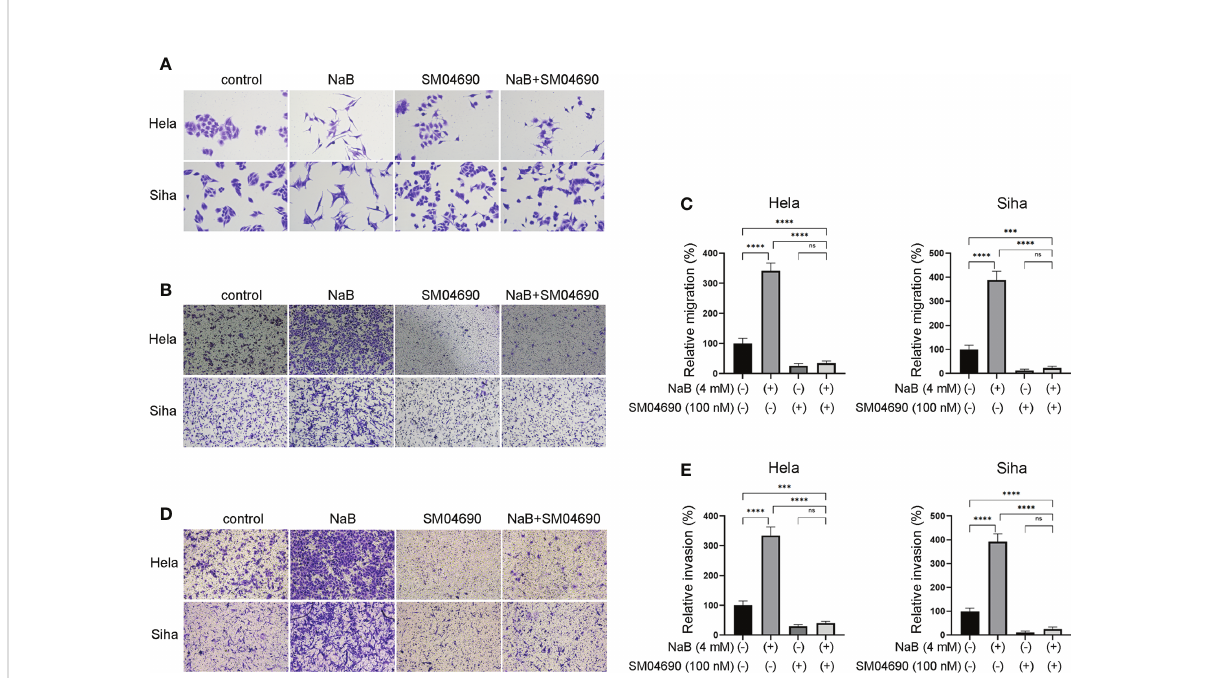
FIGURE 5 Wnt pathway inhibitor SM04690 relieved the effects of NaB on migration, invasion, and EMT process. (A) Spindle-shaped morphological changes of Hela and Siha cells were observed after crystal violet staining. (B, C) Migration and (D, E) invasion were detected by Transwell assays. Hela and Siha cells were treated with NaB (4 mM) alone or in combination with SM04690 (100 m M). Signi fi cance was examined by one-way ANNOVA ( ns P > 0.05, ***P < 0.001, ****P < 0.0001). NaB, sodium butyrate. Magni fi cation: 200